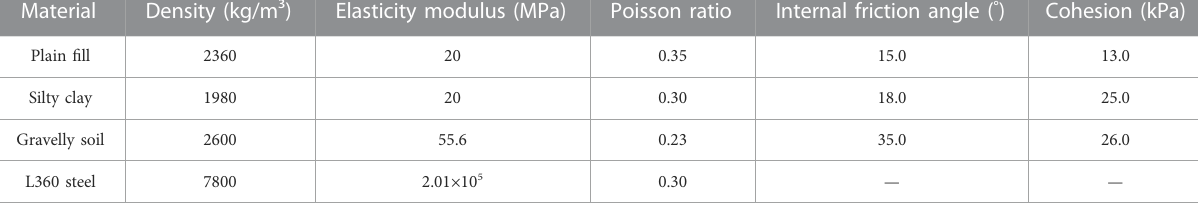
TABLE 3 Values of landslide soil and pipeline parameters.